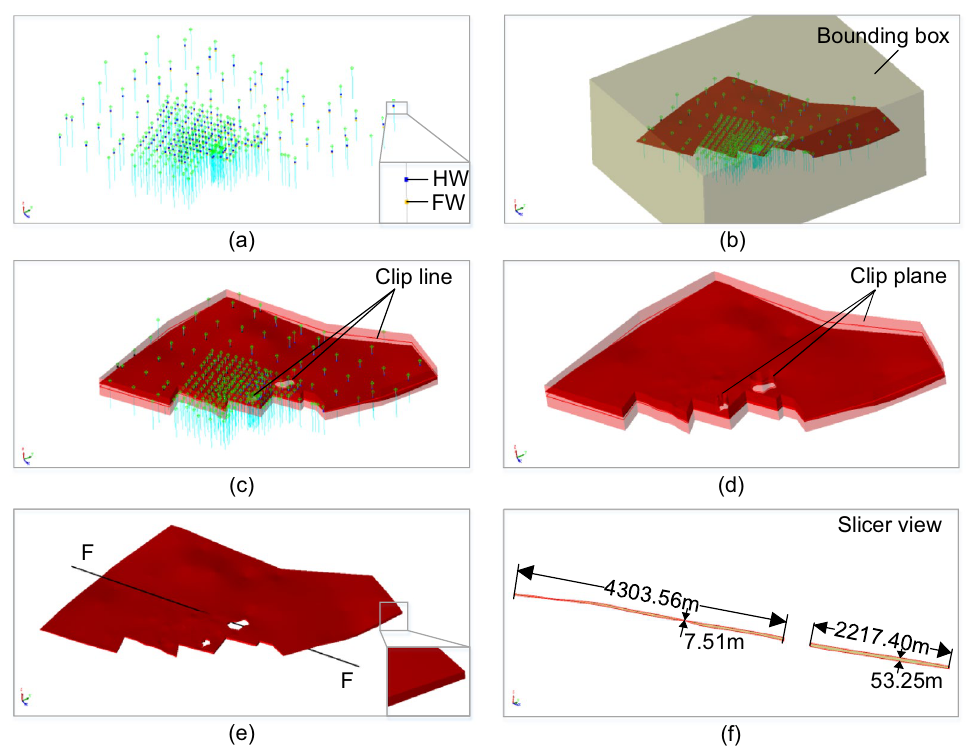
Figure 12. Implicit modeling of a narrow vein orebody model. ( a ) Drillhole data; ( b ) rectangle bounding box; ( c ) initial model; ( d ) clipped model; ( e ) final model; ( f ) slicer